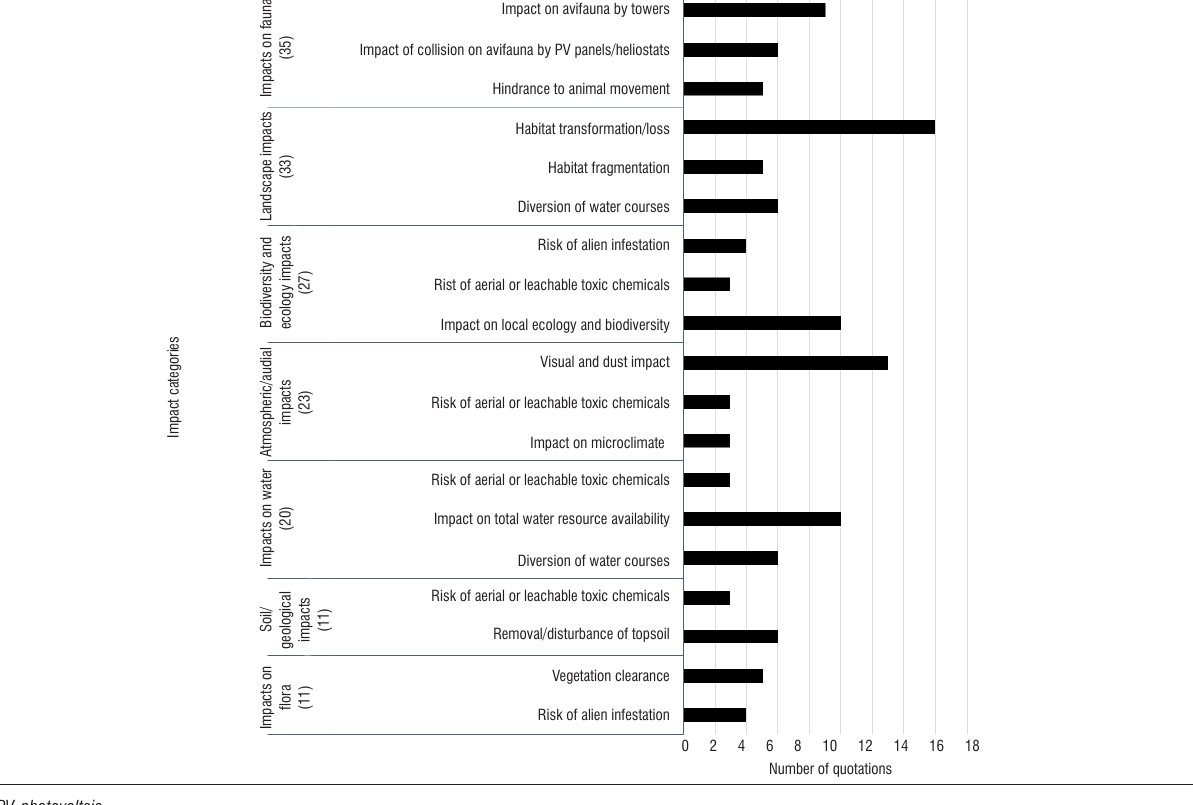
Summary of the seven biophysical impact categories in descending order by total number of quotations per category as indicated in brackets. Biophysical impacts that were mentioned more than twice per impact category are listed per impact category. A quotation represents a single event in which the specific impact was